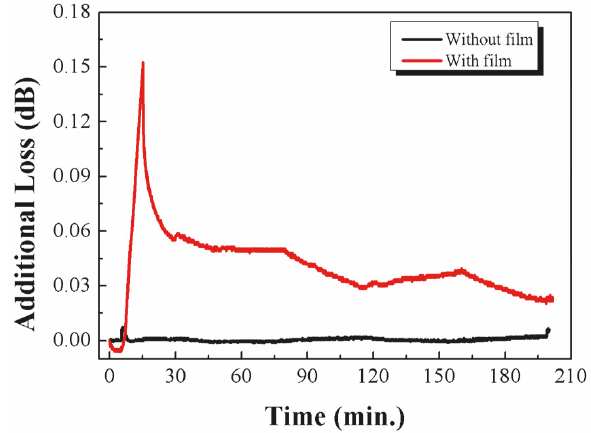
Figure 5: Sensitivity and recovery responses of coated and naked OMF sensors (diameter, ∼ 5 𝜇 m) to AMCs at a concentration of 106.3 mg/m 3